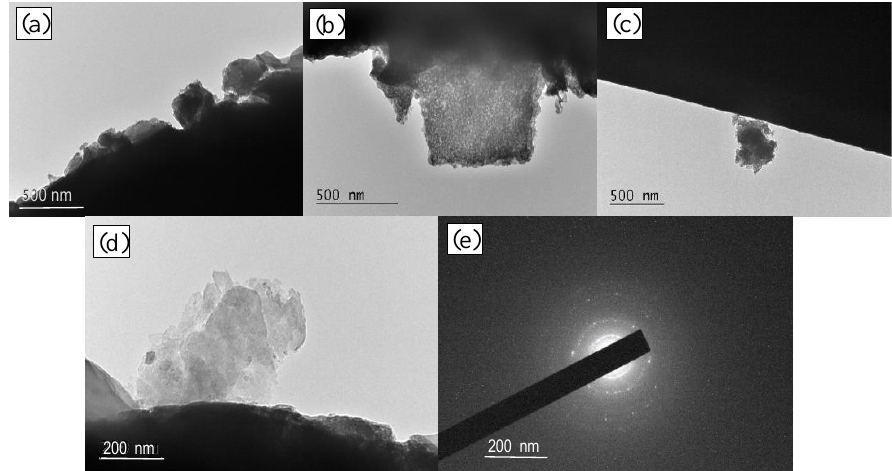
Figure 3. TEM images of PA30 at: a low magnification ( a – c ); and at a high magnification ( d ); ( e ) Electron diffraction pattern showing poly rings from zinc oxide nanoparticles.